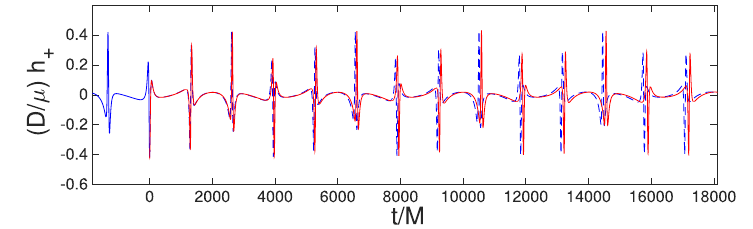
Fig. 33 Comparing the waveforms of the EMRIs with (red, solid) and without (blue, dashed) a glitch. The MBH has a mass of M ¼ 10 6 M (cid:3) and a spin parameter of 0.9. The total mass of the BH ? BH is m ¼ 20 M (cid:3) , and D refers to the luminosity distance. In this example, the centre of mass of the stellar-mass BH ? BH initially is moving inside the equatorial plane of the MBH with an orbital eccentricity of e ¼ 0 : 7 and a semilatus rectum of p ¼ R ð 1 (cid:4) e 2 Þ ¼ 17 r g. At the time t ¼ 0 a kick to the centre-of-mass velocity of the binary happens, in the polar direction and with a magnitude of 1500kms (cid:4) 1 . As a result, the orbital parameters change to p ¼ 16 : 9990 r g and e ¼ 0 : 7019, and the orbital plane of the EMRI becomes inclined by i ¼ 0 : 5233 (cid:10) relative to the equatorial plane of the